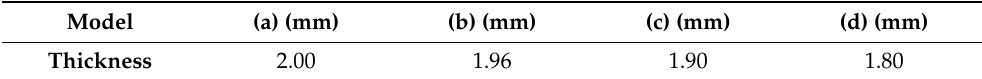
Table 5. Models with different wall thickness.